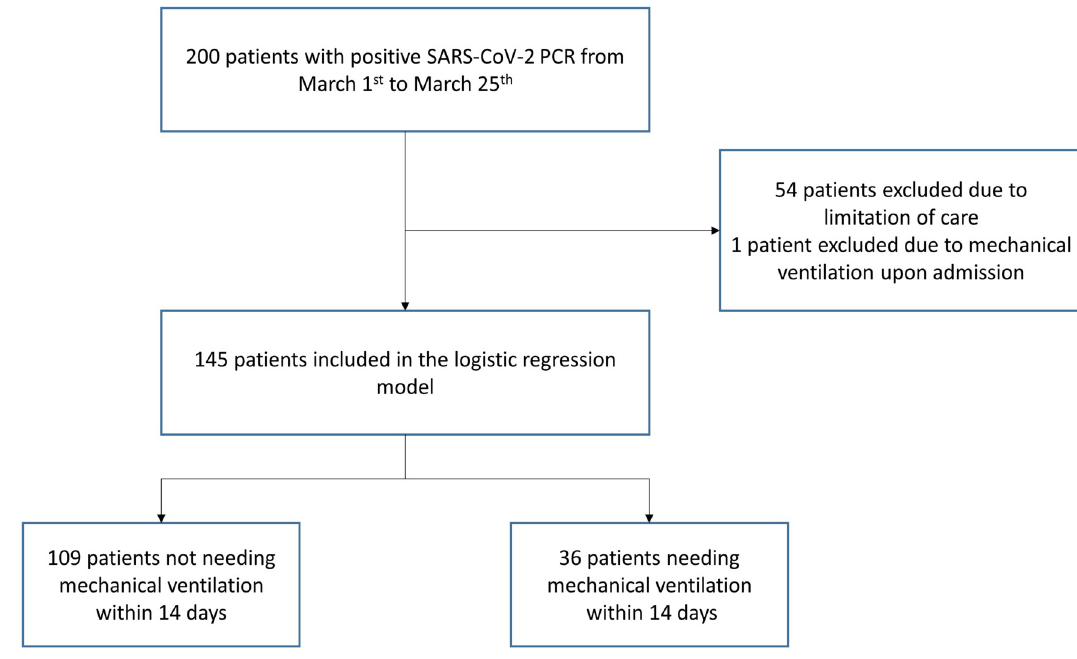
Fig 1. Patient’s selection for univariate and multivariate